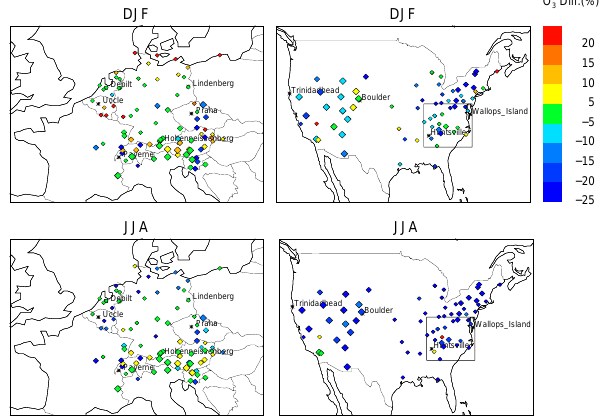
Fig. 8. Relative difference between the median ozone from sur- face stations and the median of regionally aggregated ozone from ozonesonde observations for Western Europe and the US, shown as colored diamonds. The locations of ozone soundings included in the regional aggregate are shown as black stars. Different symbol sizes indicate the altitude information of surface stations, small: 0– 500m, medium: 500–1500m, larger: > 1500m. Similar altitude in- tervals of surface ozone and ozonesonde measurements were com- pared (see text for more